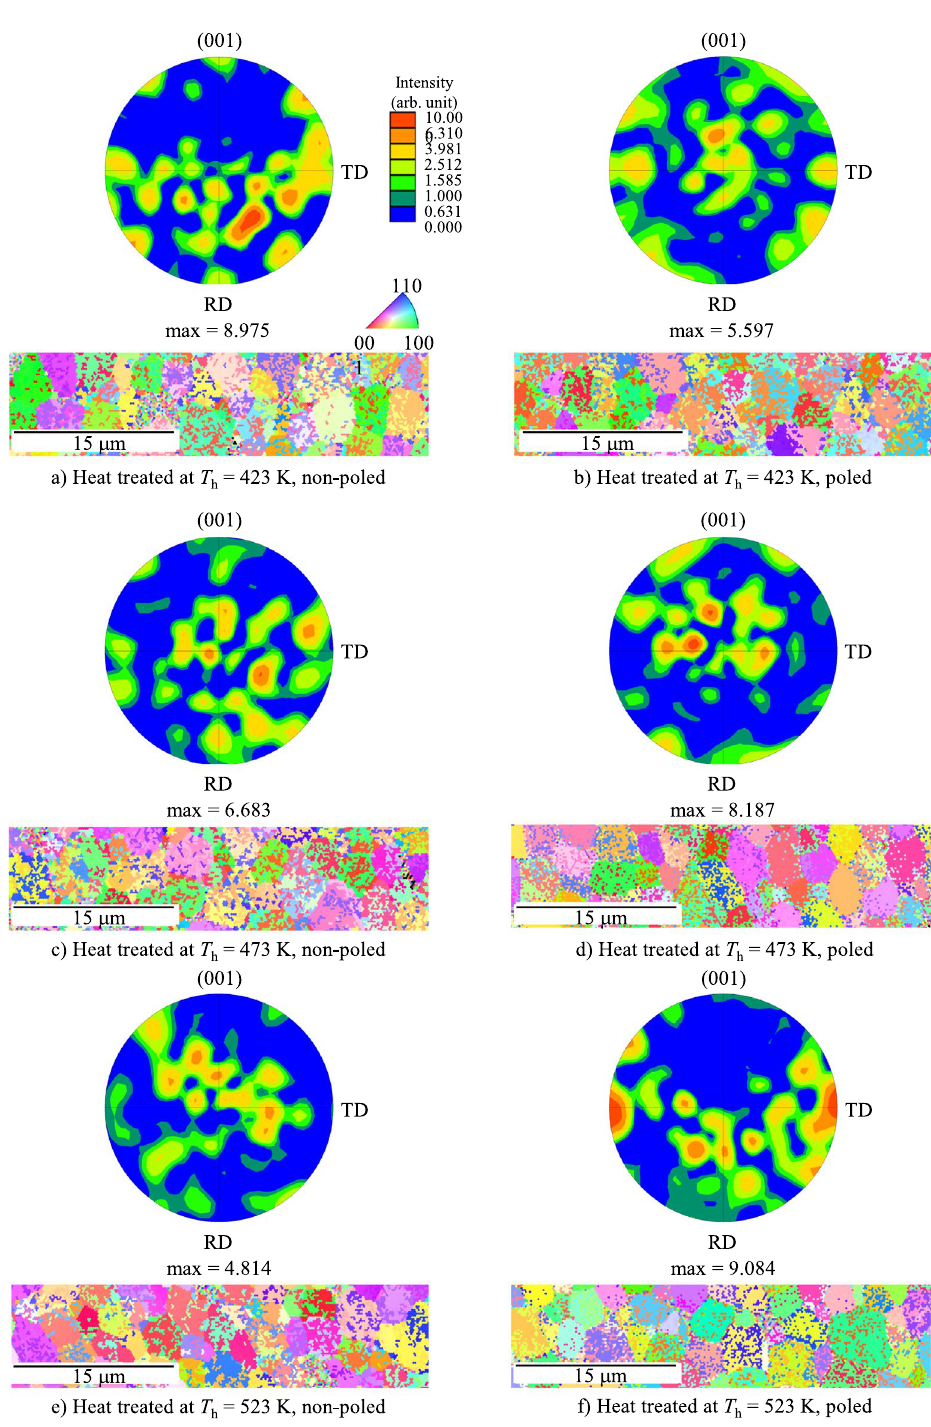
Fig. 3 Pole figures of heat-treated PZT/Al with EBSD maps that use an IPF coloring. a Th = 423 K, non-poled, b Th = 423 K, poled, c Th = 473 K, non-poled, d Th = 473 K, poled, e Th = 523 K, non-poled, and f Th = 523 K, poled. Before polarization, depolarization occurs